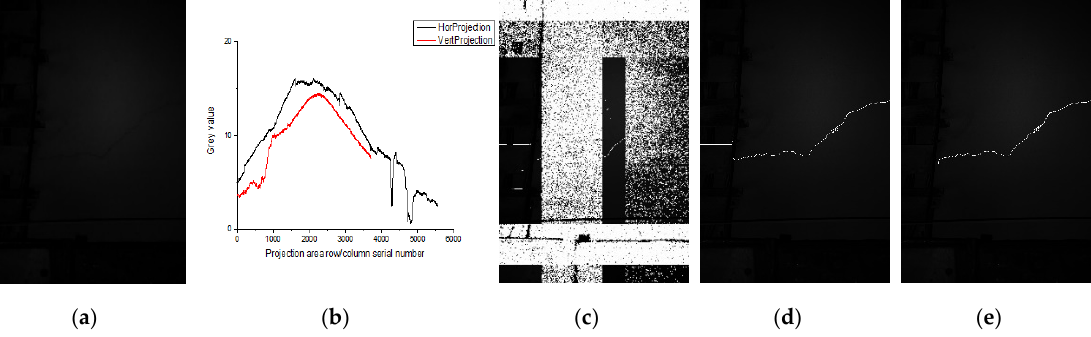
projection curve of image 2; ( c ) DPG detection result; ( d ) crack extraction results; ( e ) manual